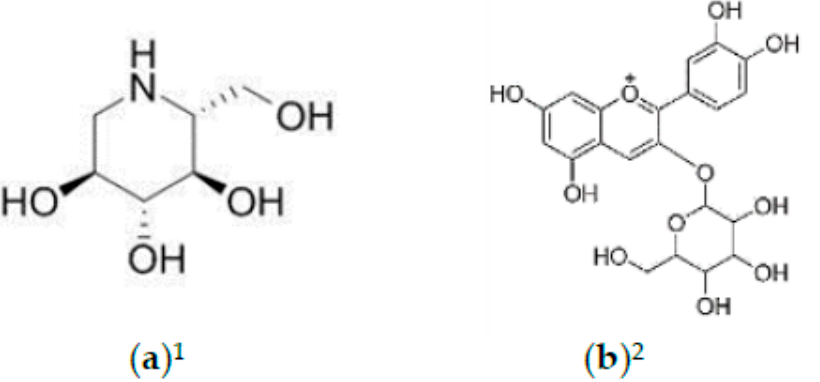
Figure 4. Structures of ( a ) 1-deoxynojirimycin (DNJ) and ( b ) cyanidin-3-O-glucoside. 1 Refers to compounds in M. alba leaves; 2 refers to compounds in M. alba fruit.